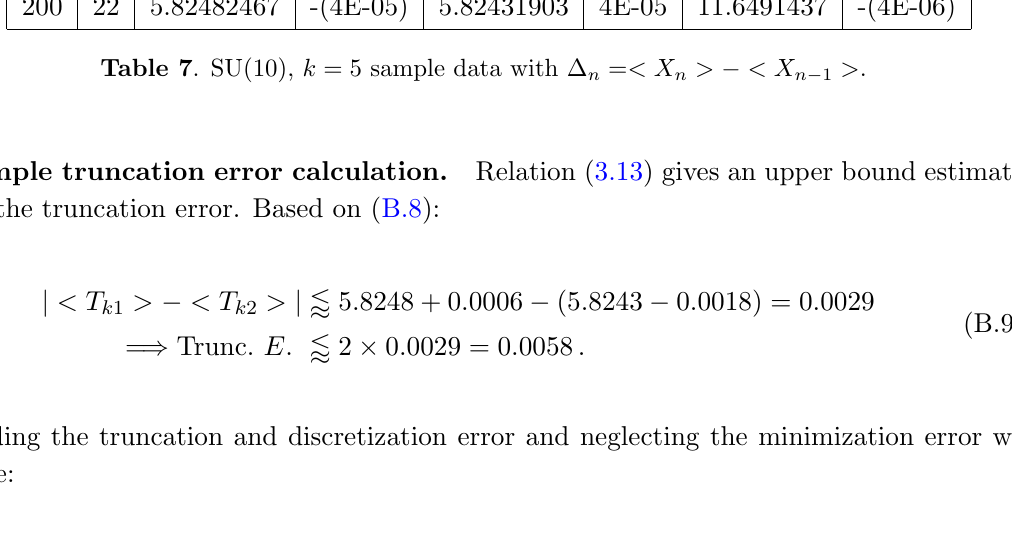
Table 7 . SU(10), k = 5 sample data with (cid:1) n = < X n >